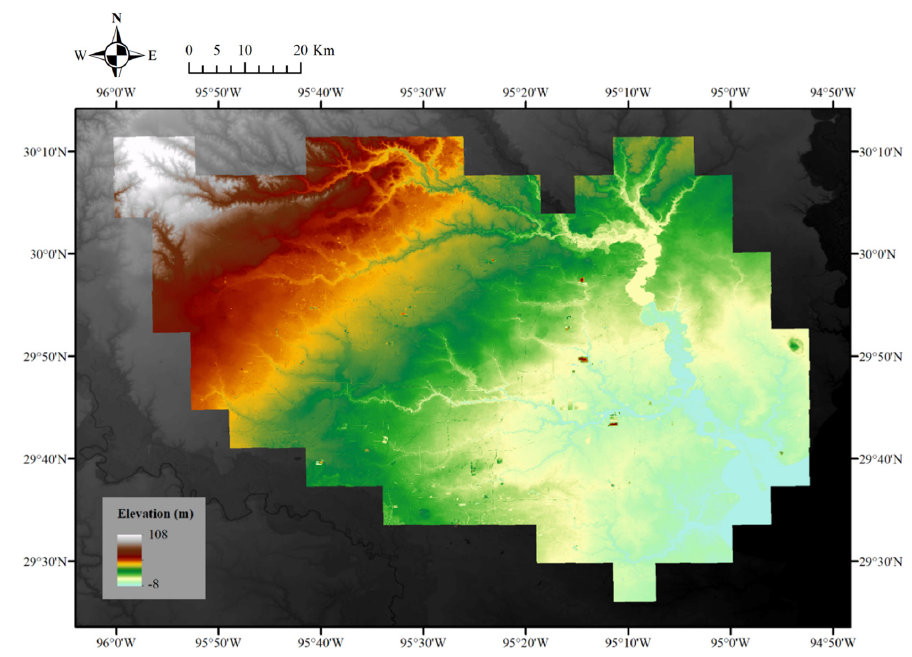
Figure 3. Elevation of Harris, Texas. Remote Sens. 2020 , 12 , x FOR PEER REVIEW